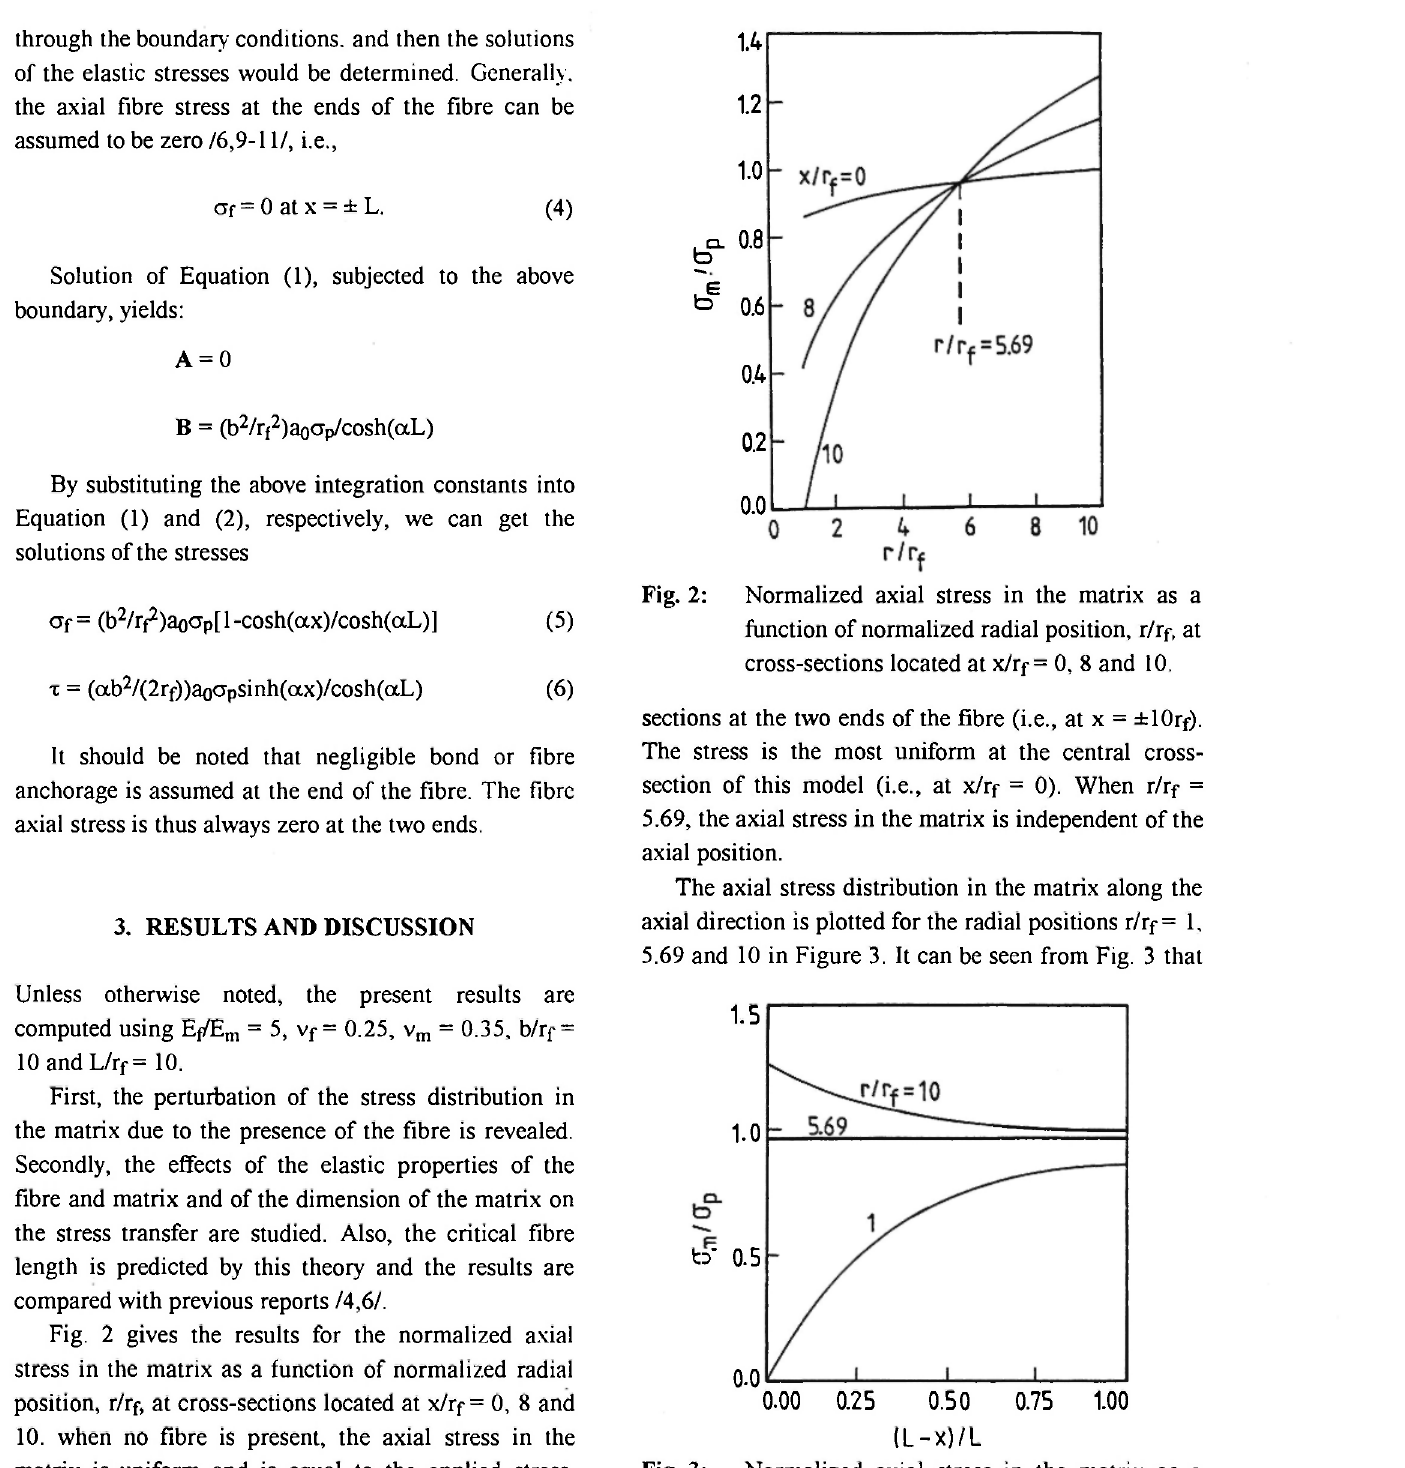
Fig. 3: Normalized axial stress in the matrix as a function of normalized axial position. (L- x)/L, at cross-sections located at r/rf = 1, 5.69 and